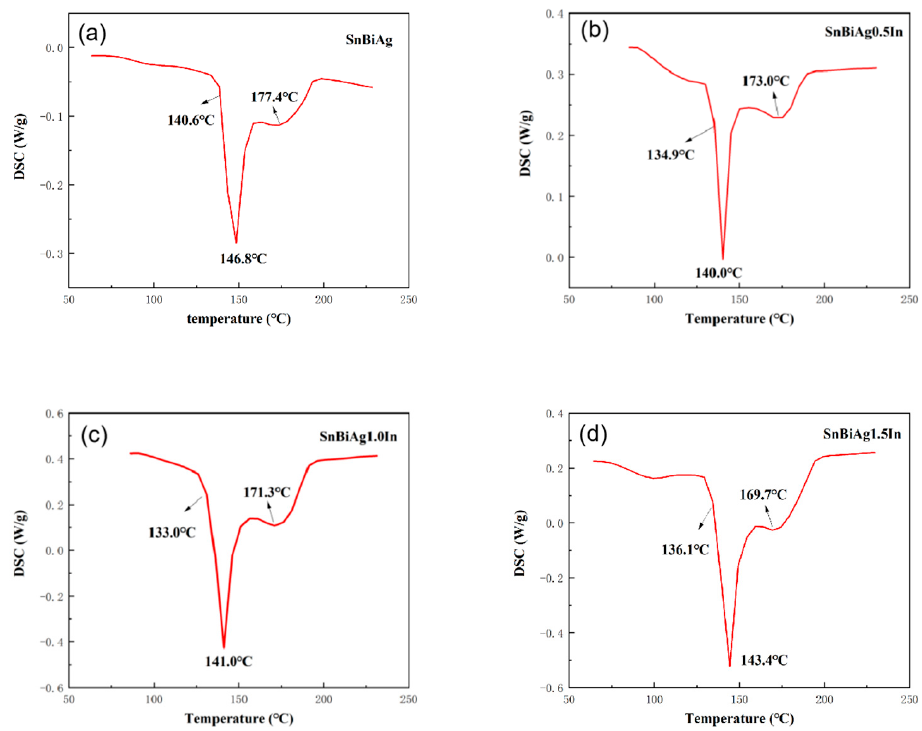
Figure 2. DSC curves of SnBiAg–xIn (x = 0, 0.5, 1.0, 1.5) alloy solders: ( a ) SnBiAg, ( b ) SnBiAg0.5In, ( c ) SnBiAg1.0In, and ( d ) SnBiAg1.5In.